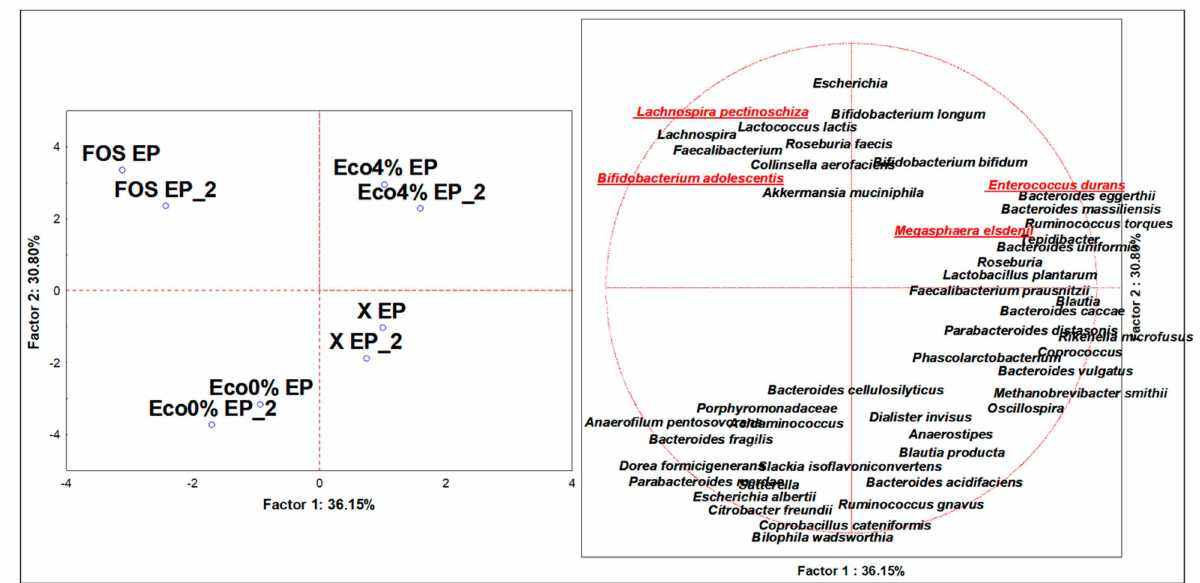
Figure 1. Principal component’s analysis (PCA) of relative abundances (%) of significative (ANOVA p < 0.05) assigned Operational Taxonomic Units (OTUs) at the species level, after 24 h (EP = Endpoint; EP_2 = duplicate sample) of in vitro batch culture fermentations inoculated with human feces ( n = 3 healthy donors) and administrated with FOS, Eco0%, and Eco4% as the substrates and a blank control (X). Variables in red font are the main descriptors of Eco4% or FOS